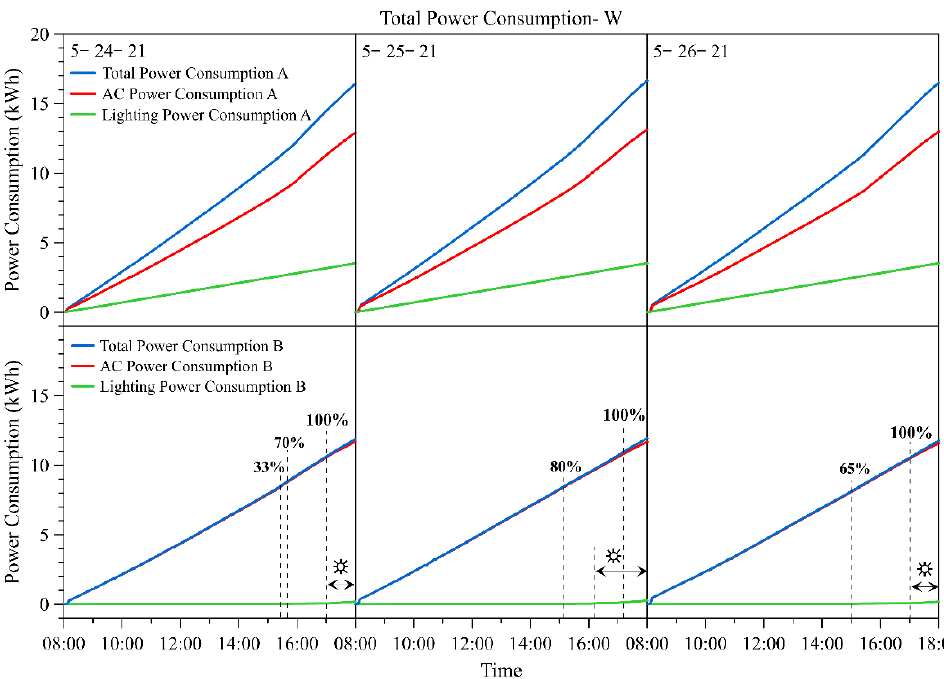
Figure 8. Cumulative power consumption record of West-facing window.